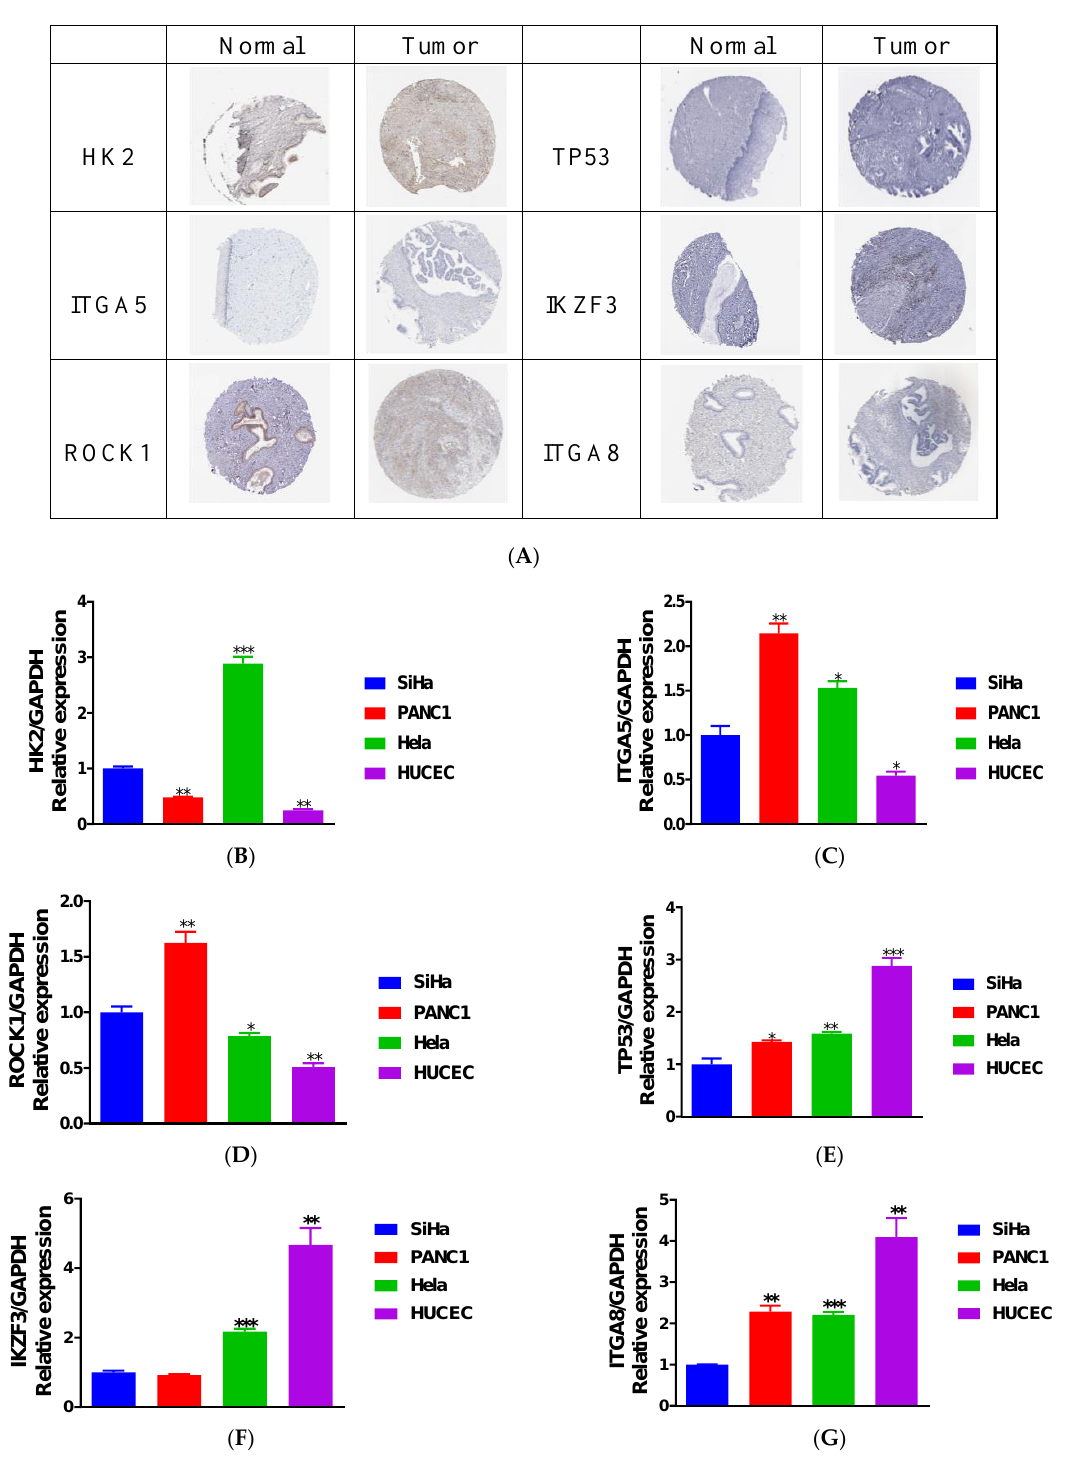
Figure 8. Immunohistochemistry (IHC) and the expression of the 6-ANRG model in the cervical cancer cell lines. ( A ) The IHC pictures derived from the Human Protein Atlas (HPA) database show trends towards differential expression in both the tumor and normal samples. ( B – G ) The expression levels of the six anoikis-related genes in the Hela and SiHa cell lines compared to the PANC-1 (positive control) and HUCEC (negative control) cell lines. SiHa: the human cervical squamous cell carcinoma cell line; Hela: the human cervical adenocarcinoma cell line; HUCEC: the normal human cervix cell line; PANC-1: the human pancreatic cancer cell line. * p < 0.05, ** p < 0.01, and *** p <